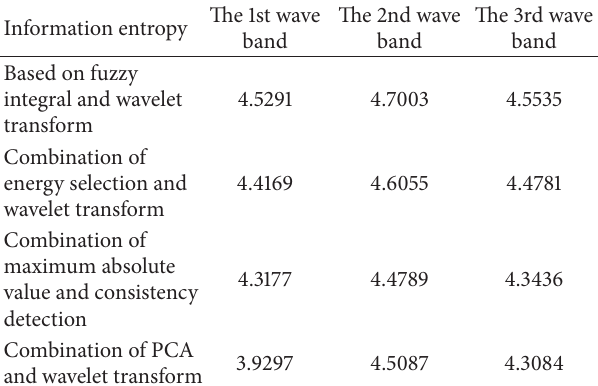
Table 8: Information